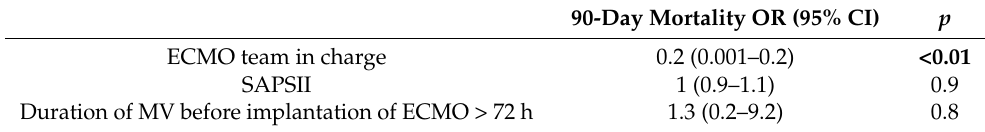
Table 3. Association between having an ECMO team in charge of the patient and 90-day mortality.